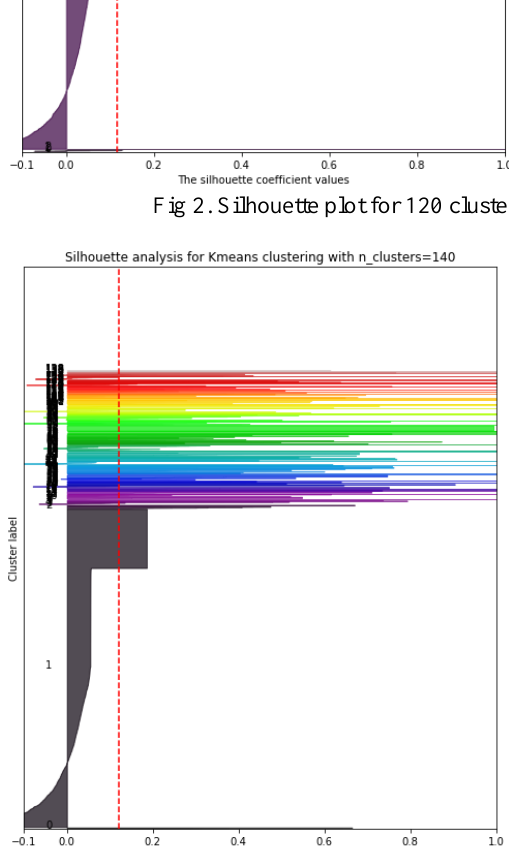
Fig 3. Silhouette plot for 140 clusters